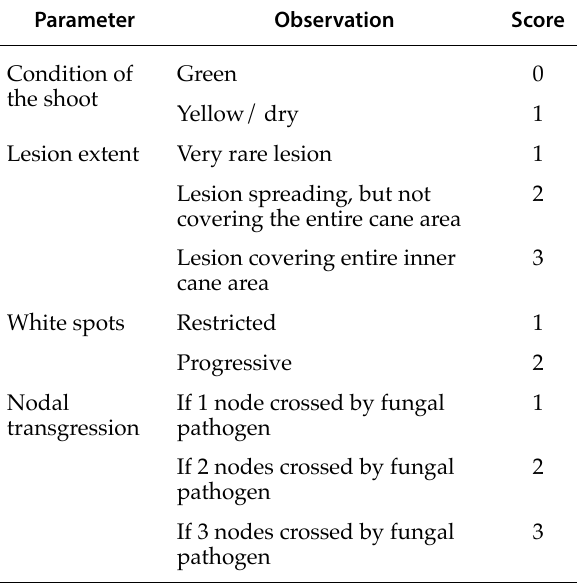
Table 1. Parameters used for determining red rot severity scores on sugarcane, caused by Colletotrichum falcatum